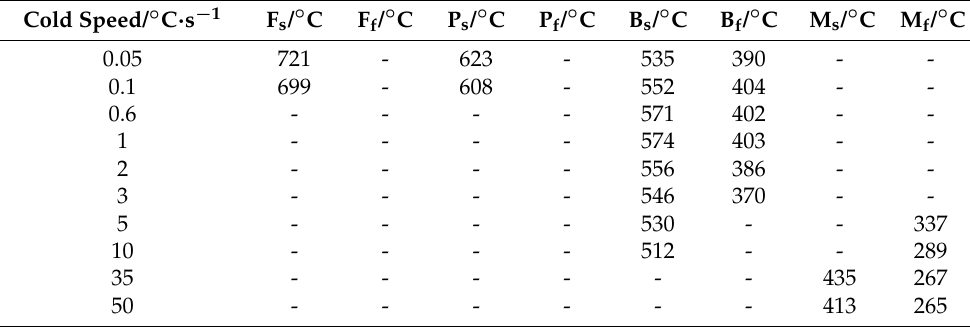
Table 3. The phase transition points of the specimens after austenitizing at 920 ◦ C.